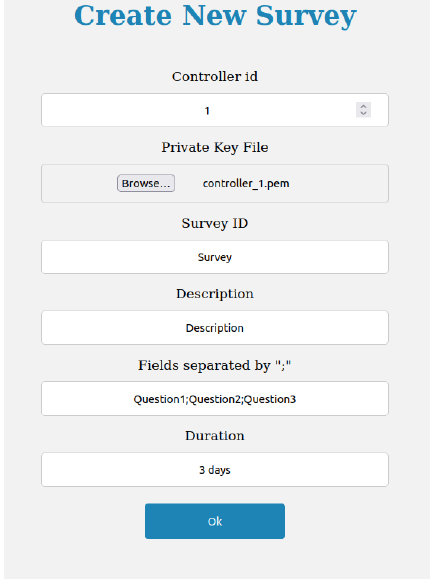
Figure 3. Create Survey Web Page.